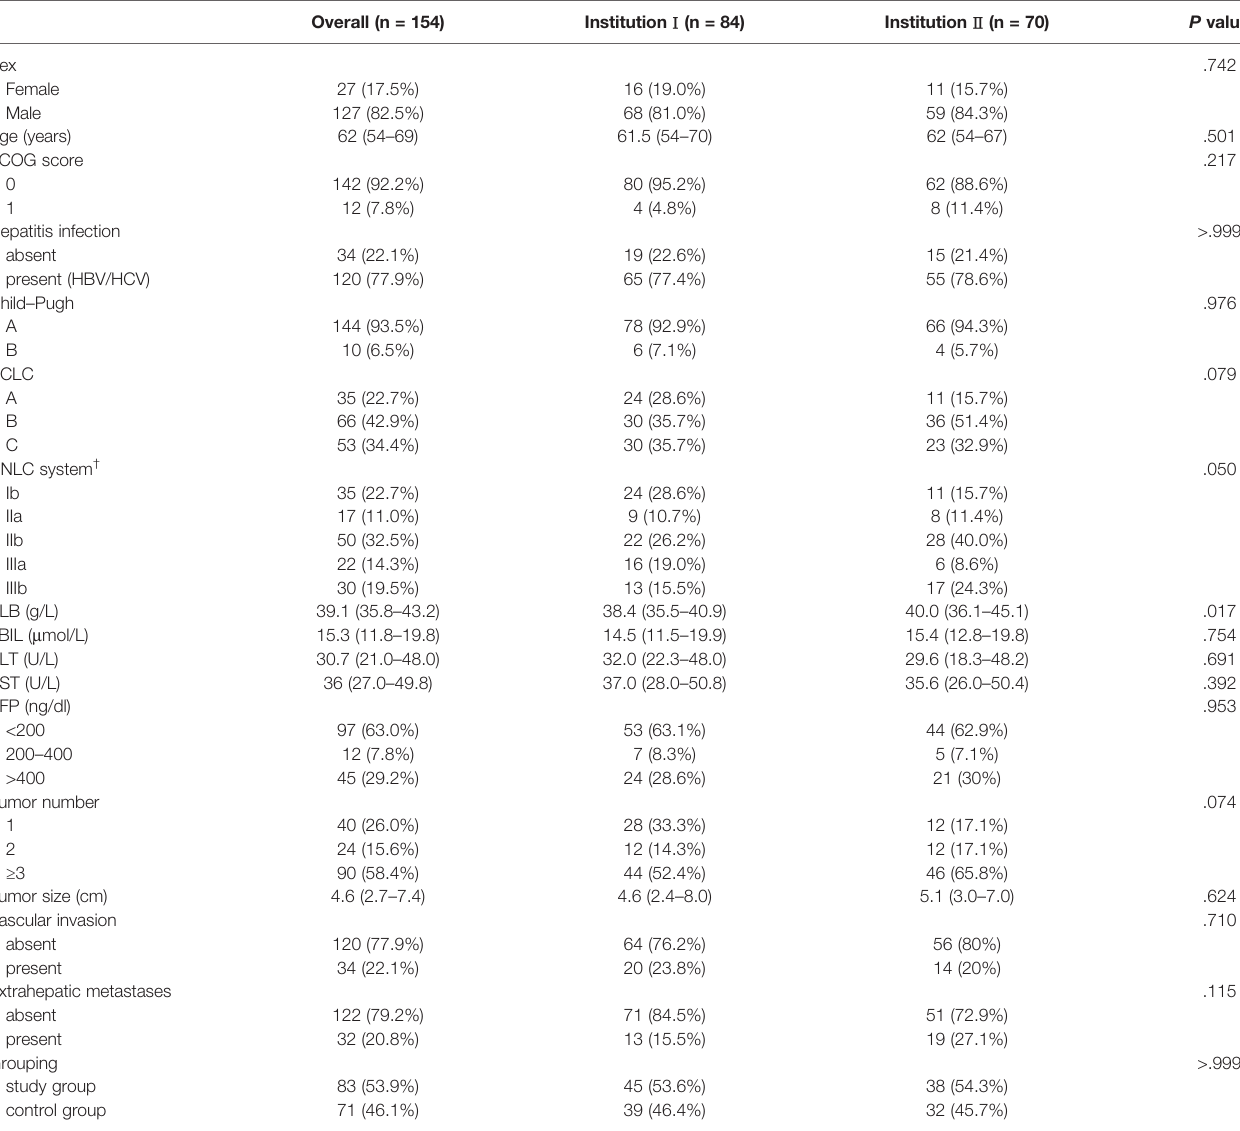
TABLE 2 | Patient characteristics of the two